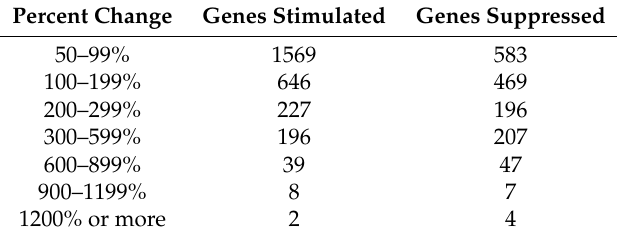
Table 1. Estimate of number of genes affected by glycyl- L -histidyl- L -lysine (GHK) [5]. Percent Change Genes Stimulated Genes Suppressed 50–99%